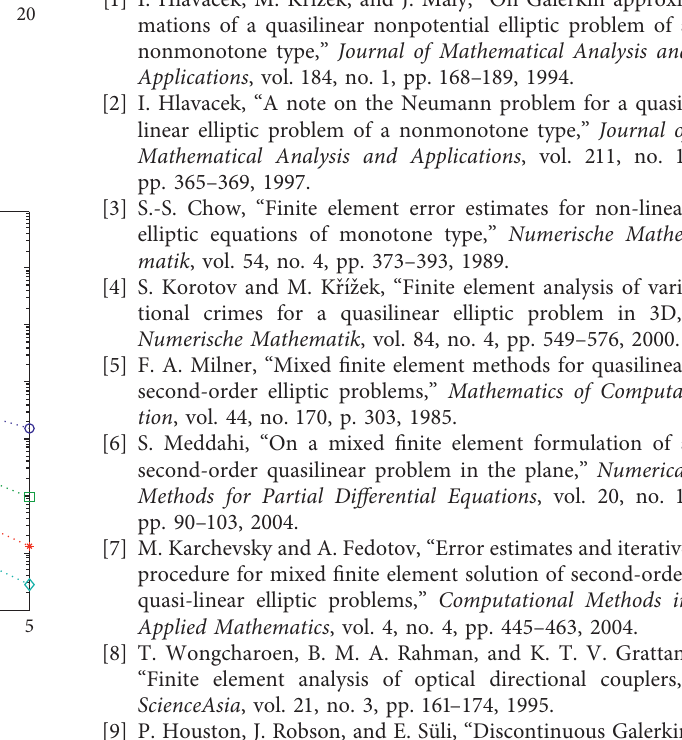
Figure 5: L ∞ ( Γ ) errors with different d ( N � 20 ) E